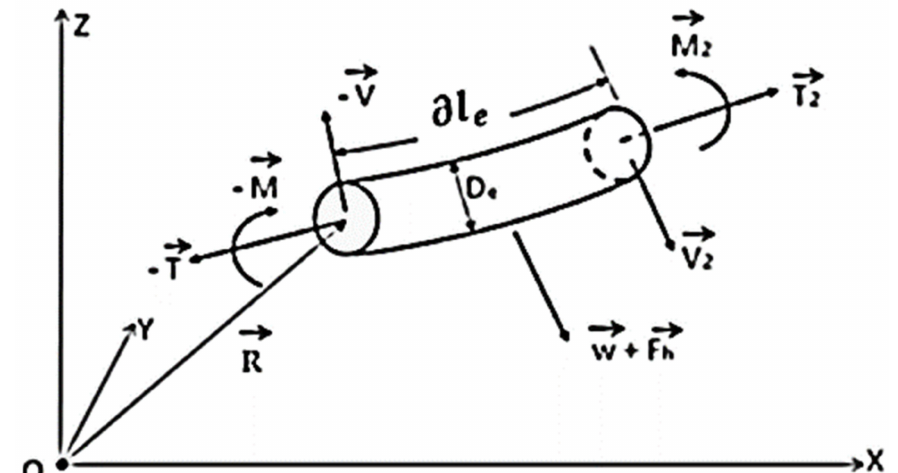
Figure 5. Illustration of forces on cable